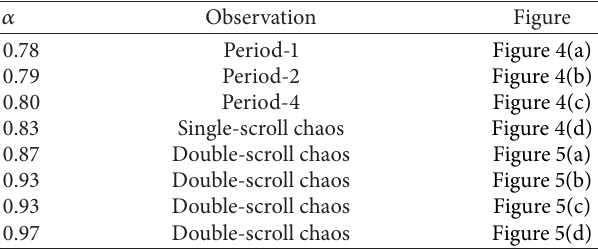
Table 2: Dynamics of system (13) with 𝑏 22 = 3.0 , 𝑐 22 = −2.5 , and different 𝛼